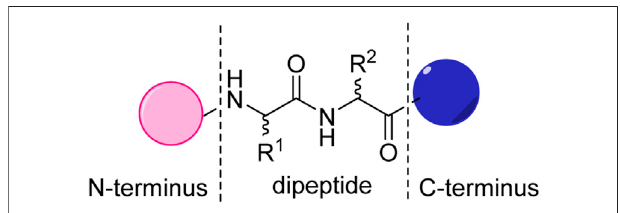
FIGURE 1 | The general structure of dipeptide